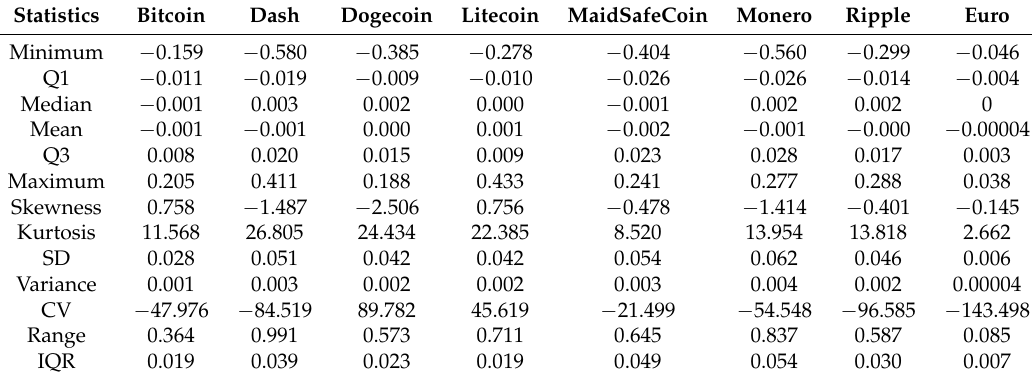
Table 2. Summary statistics of daily log returns of the exchange rates of Bitcoin, Dash, Dogecoin, Litecoin, MaidSafeCoin, Monero, Ripple and the Euro, versus the U.S. Dollar from 23 June 2014